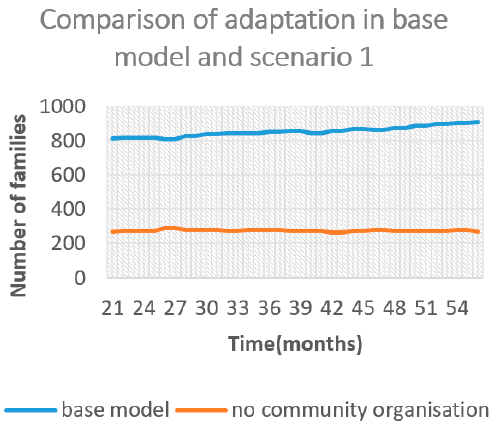
Figure 3. Adaptation outcomes for the base model and scenario test.